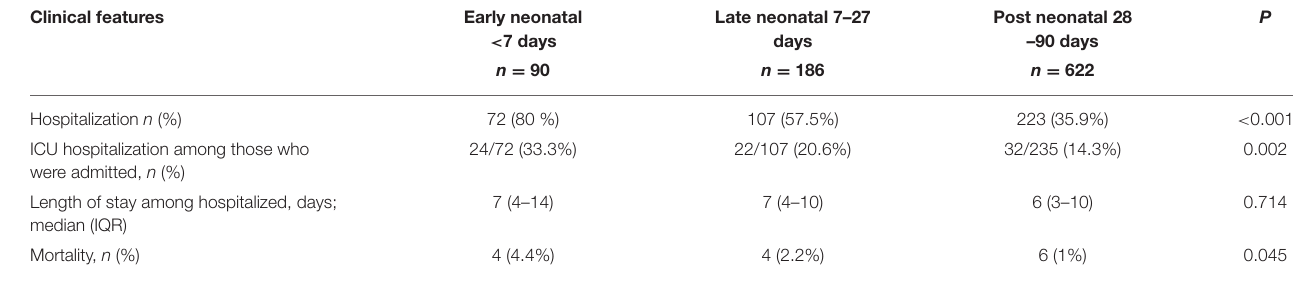
TABLE 4 | Outcomes according to age at time of